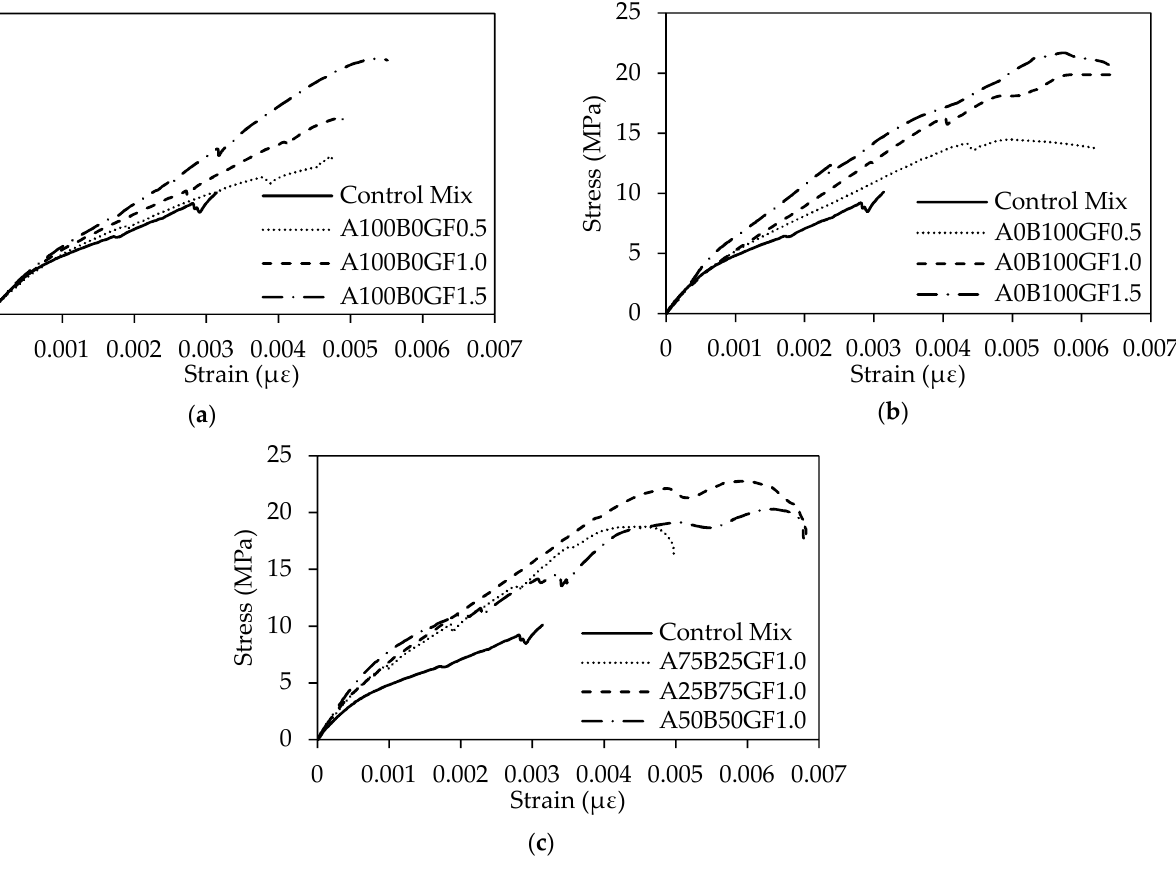
Figure 10. Typical compression stress–strain curves of cylinder concrete specimens for ( a ) Series A, ( b ) Series B, and ( c ) Series C.